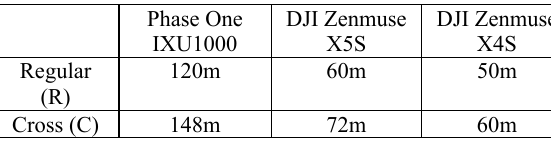
Table 2. Systems, flight arrangement and altitude